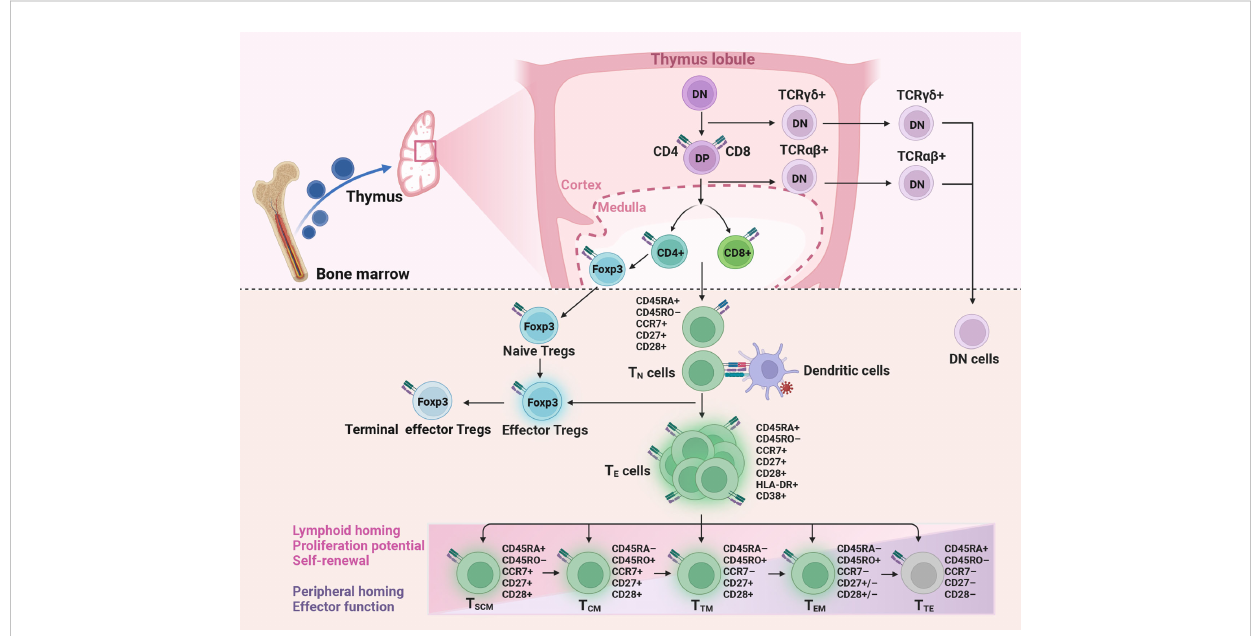
FIGURE 1 Production and differentiation of T cells. Naive CD4 + and CD8 + T (T N ), naive regulatory T (Tregs) cells, and double-negative (DN) T cells are released from the thymus. Then CD4 + and CD8 + T cells get activated and differentiate into effector (T E ) cells after encountering antigens. Only a small part of T E develops into memory T cells, including stem-like memory (T SCM ), central memory (T CM ), transitional memory (T TM ), effector memory (T EM ), and terminal effector (T TE ) cells. In HIV immunological non-responders, the number of T N cells produced by the thymus is reduced, while the proportion of activated T cells is increased. DP, double-positive; TCR ab , T cell receptor alpha and beta; TCR gd , T cell receptor gamma and delta; Foxp3, factor forkhead box